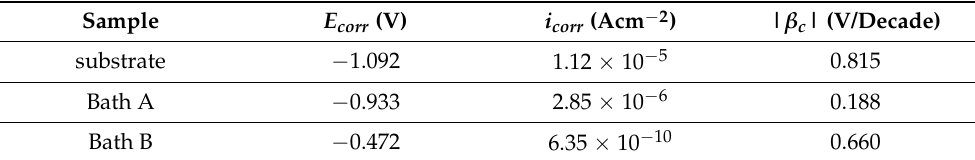
Table 1. Results of PDP tests of the substrate and PEO-coated samples immersed in 3.5 wt.% NaCl